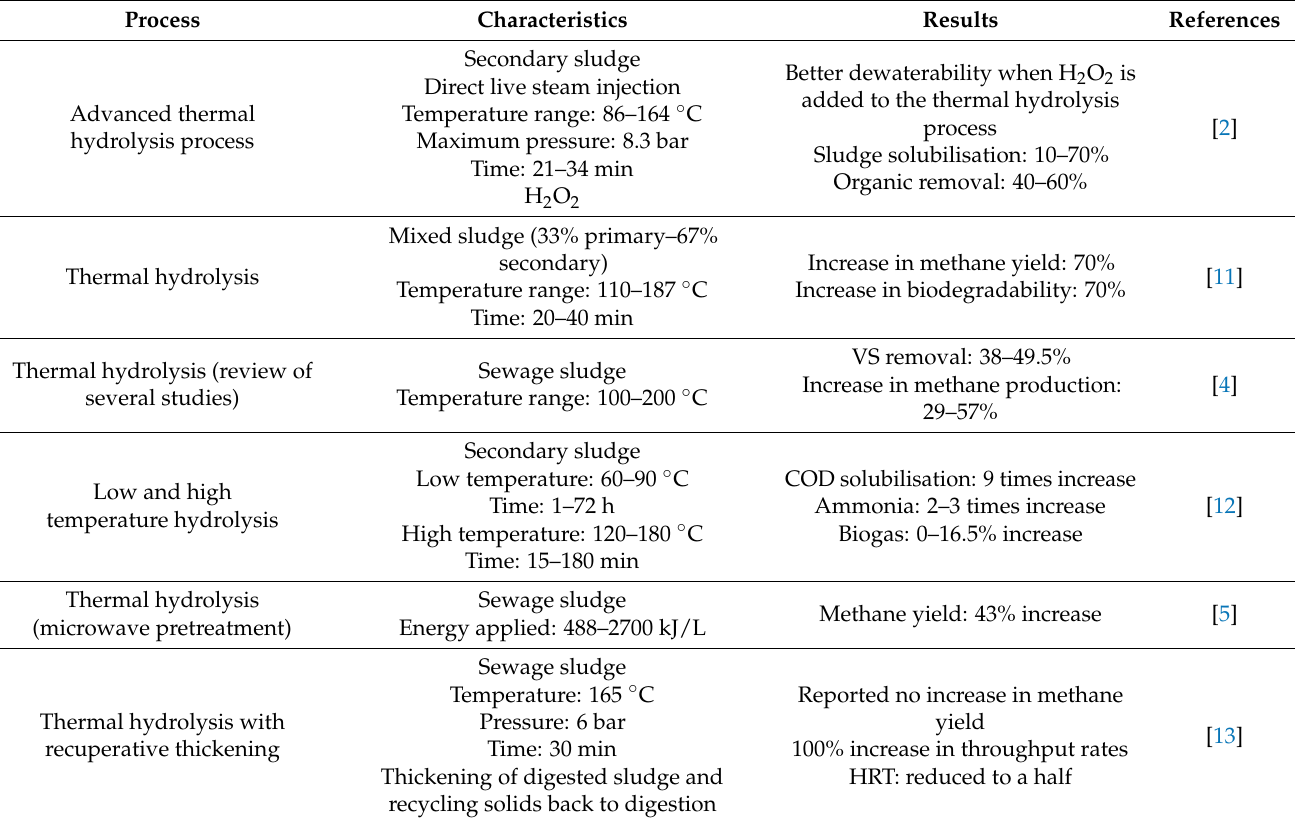
Table 1. Results reported in the literature regarding the application of thermal hydrolysis processes for enhancing anaerobic